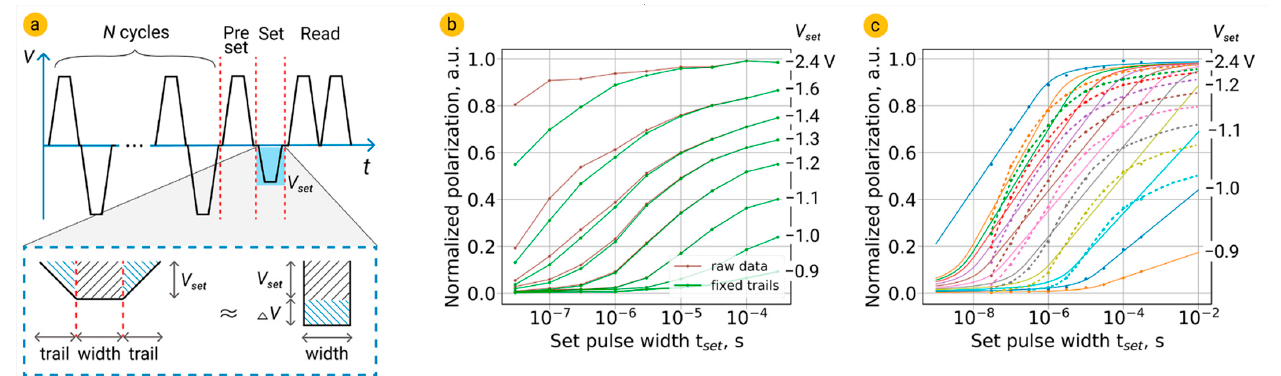
Figure 1. ( a ) The sequence of pulses used to obtain data on switching of the polarization depending on the amplitude and duration of the set pulse. Below: impact of set pulse trails to switched polarization. ( b ) Comparison of raw and corrected data. ( c ) Result of fitting of experimental dataset (points) by the classical NLS model (solid lines) and the expected shape of the curves (dotted